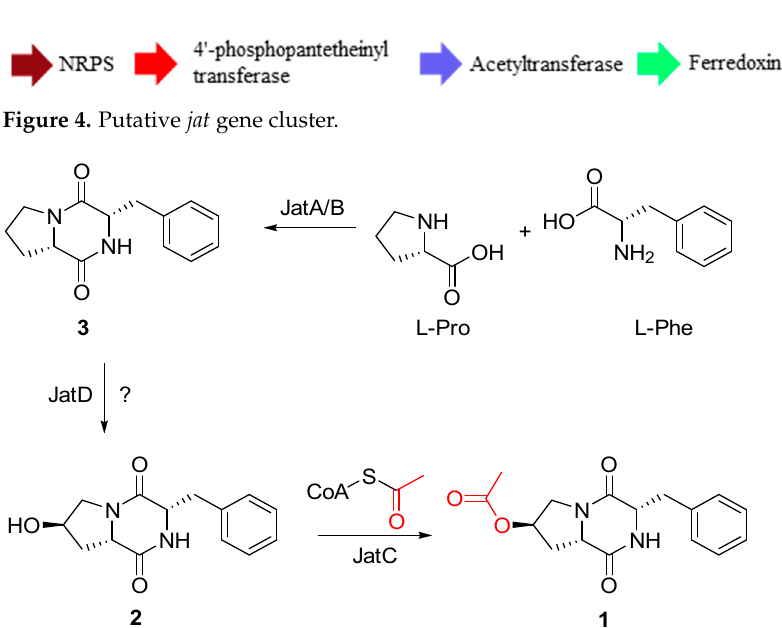
Scheme 1. Isolated compounds and proposed biosynthesis pathway for janibatide A ( 1 ).